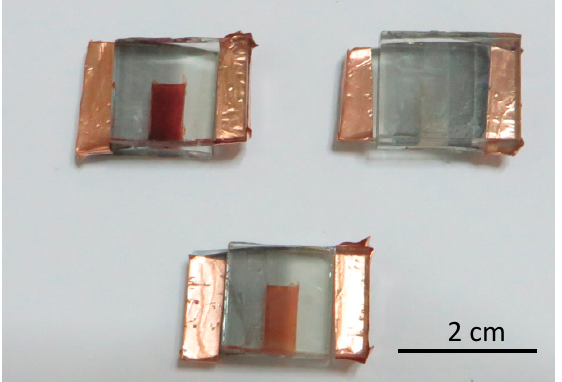
Figure 3. Images of nanoparticle (top left), nanowire (top right) and nanowire with improved dye loading (bottom) devices sensitized with N719.